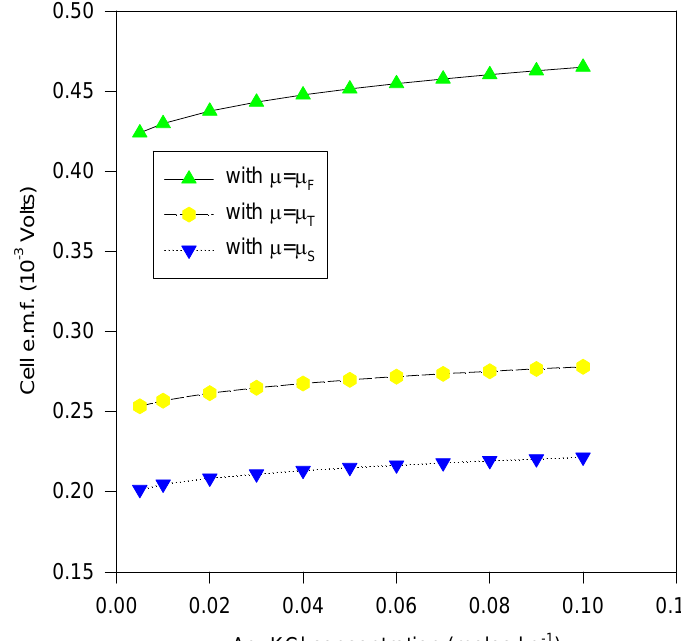
Figure 12. Cell e.m.f. for various µ, based on Born dielectric equation for KCl concentration in AgCl